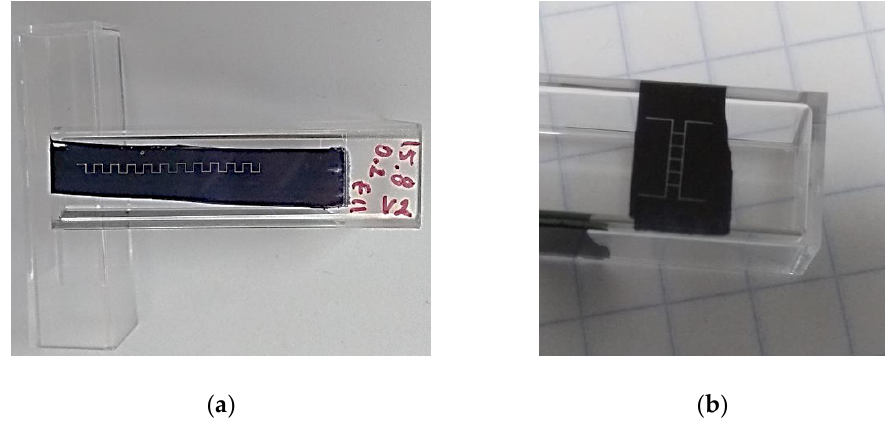
Figure 3. Micromachining by green laser ablation method. Two examples of FMLs, ( a ) and ( b ), obtained onto one side of the polystyrene spectrophotometer cuvette. ( a ) FML sample with different focal planes and ( b ) focused on a plane coincident with the ablated surface (Z = 0) (see Supplementary Information, Top view of sample and PDMS microchip Model 1).